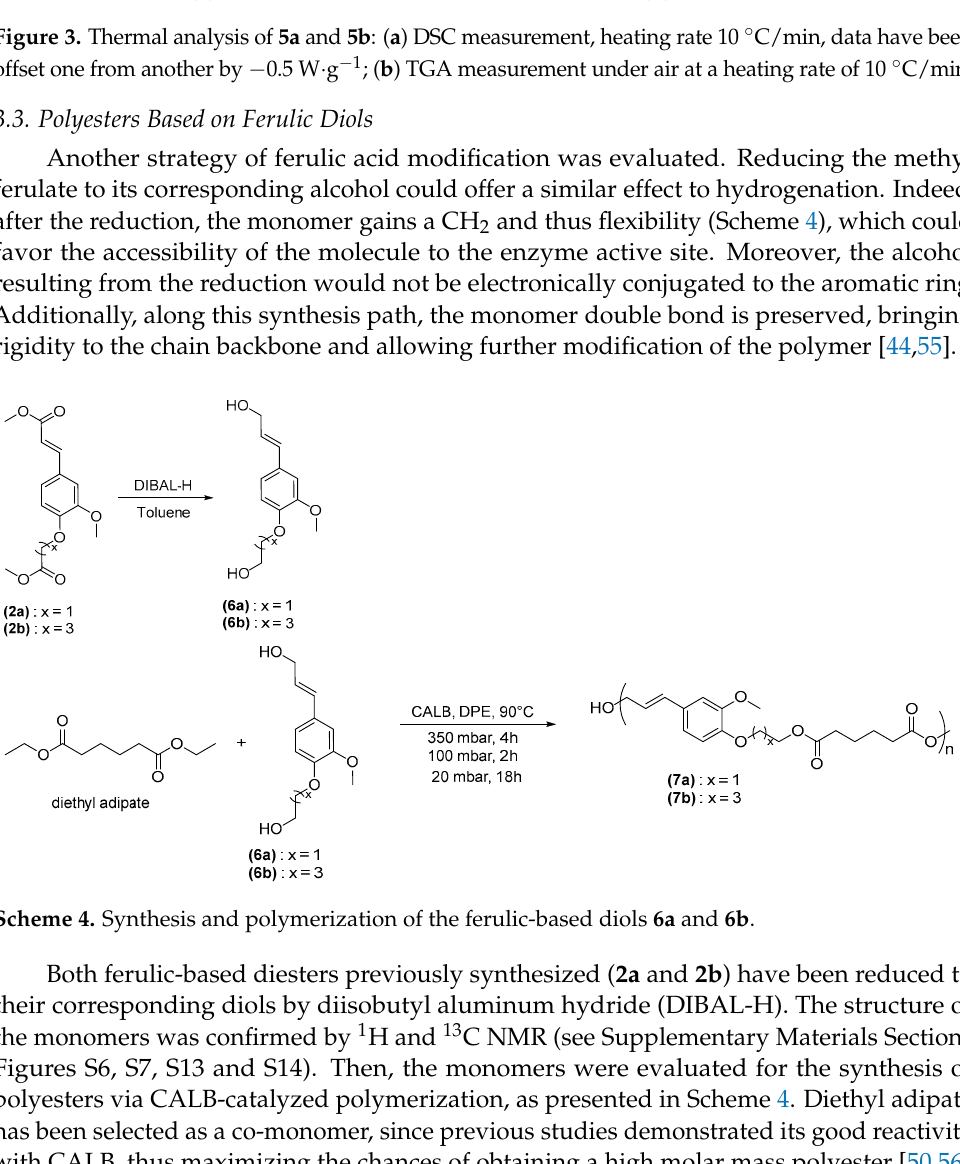
Figure 4. Molar masses of the polyesters synthesized from the ferulic-based diols.  7a ,  7b . Although the large polydispersity of the polymer does not allow obtaining quanti- tative results from the MALDI-TOF MS [58], it is possible to qualitatively compare the end groups with each other. A large number of polymeric chains are ended with both an ester and a hydroxyl group (green triangles in Figure 5a). This is expected due to the one-to-one stoichiometry of the monomers. However, a significant proportion of poly- meric chains are terminated on both ends by an ester group (red triangles in Figure 5a). This result indicates an unbalanced stoichiometry in the reaction medium with an excess of the diester. Side reactions involving one of the monomers could result in its deactiva- tion or loss of reactivity and thus unbalance the stoichiometry of the reaction. However,